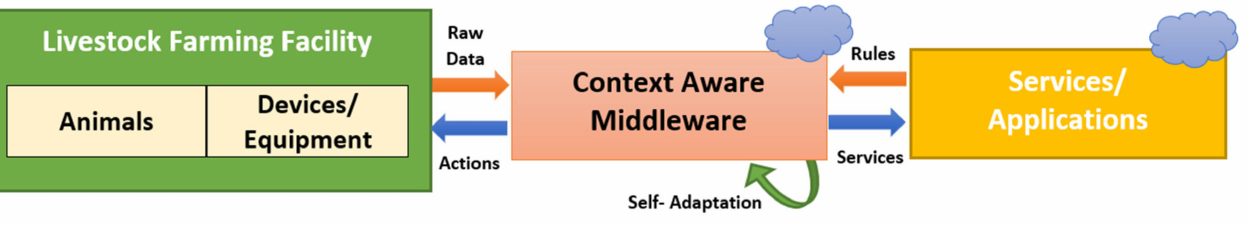
Figure 3. IFM system operational